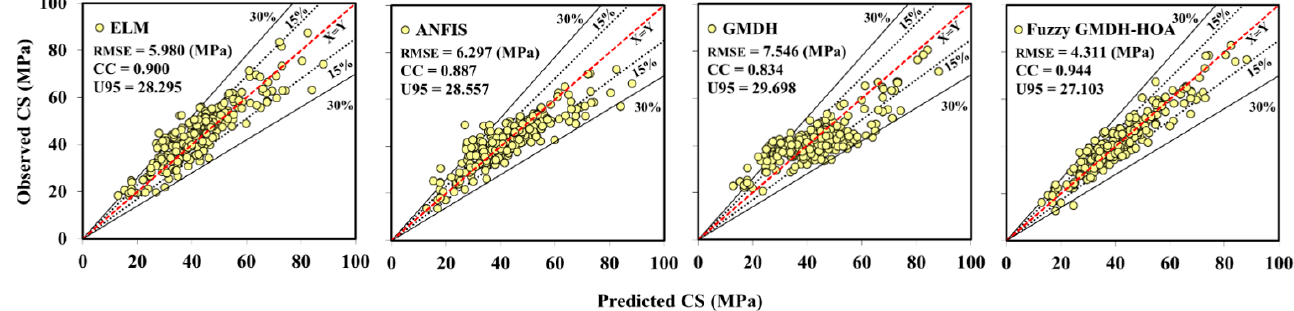
Figure 6. Training performances of proposed models for CS of RCDWAC.